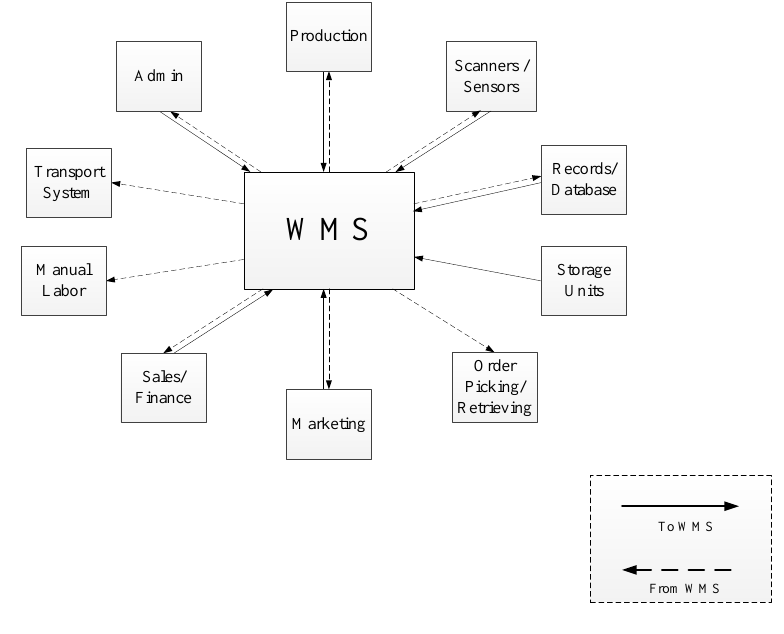
Figure 2. Context